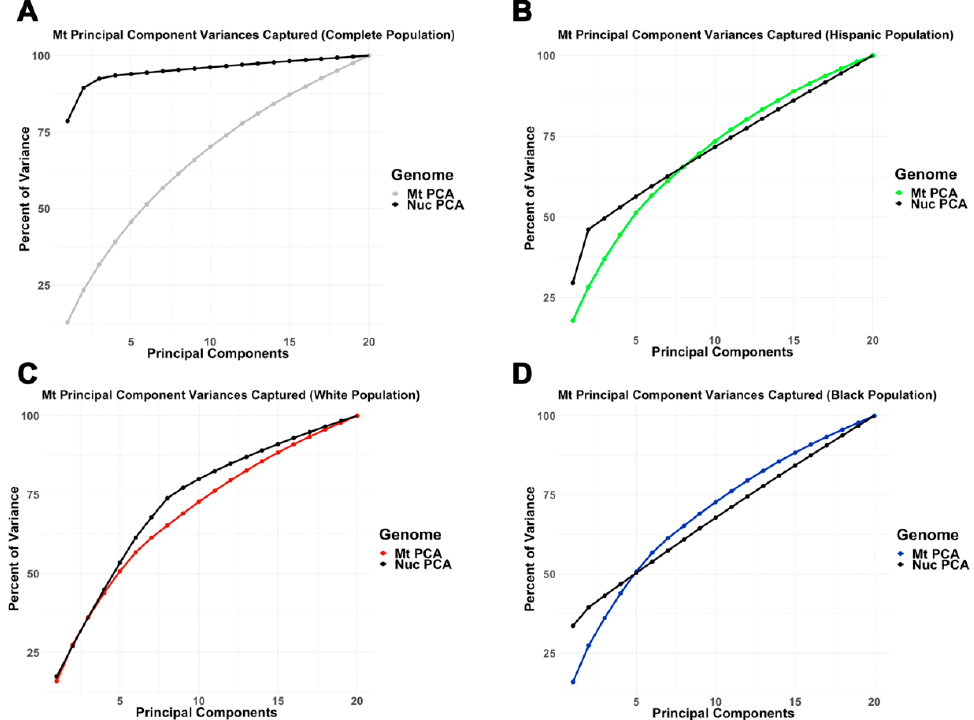
Figure 3. Comparing the amount of variance captured by nuclear and mitochondrial principal components ( A ) across all ethnicities, ( B ) among Hispanic, ( C ) among White, and ( D ) among Black